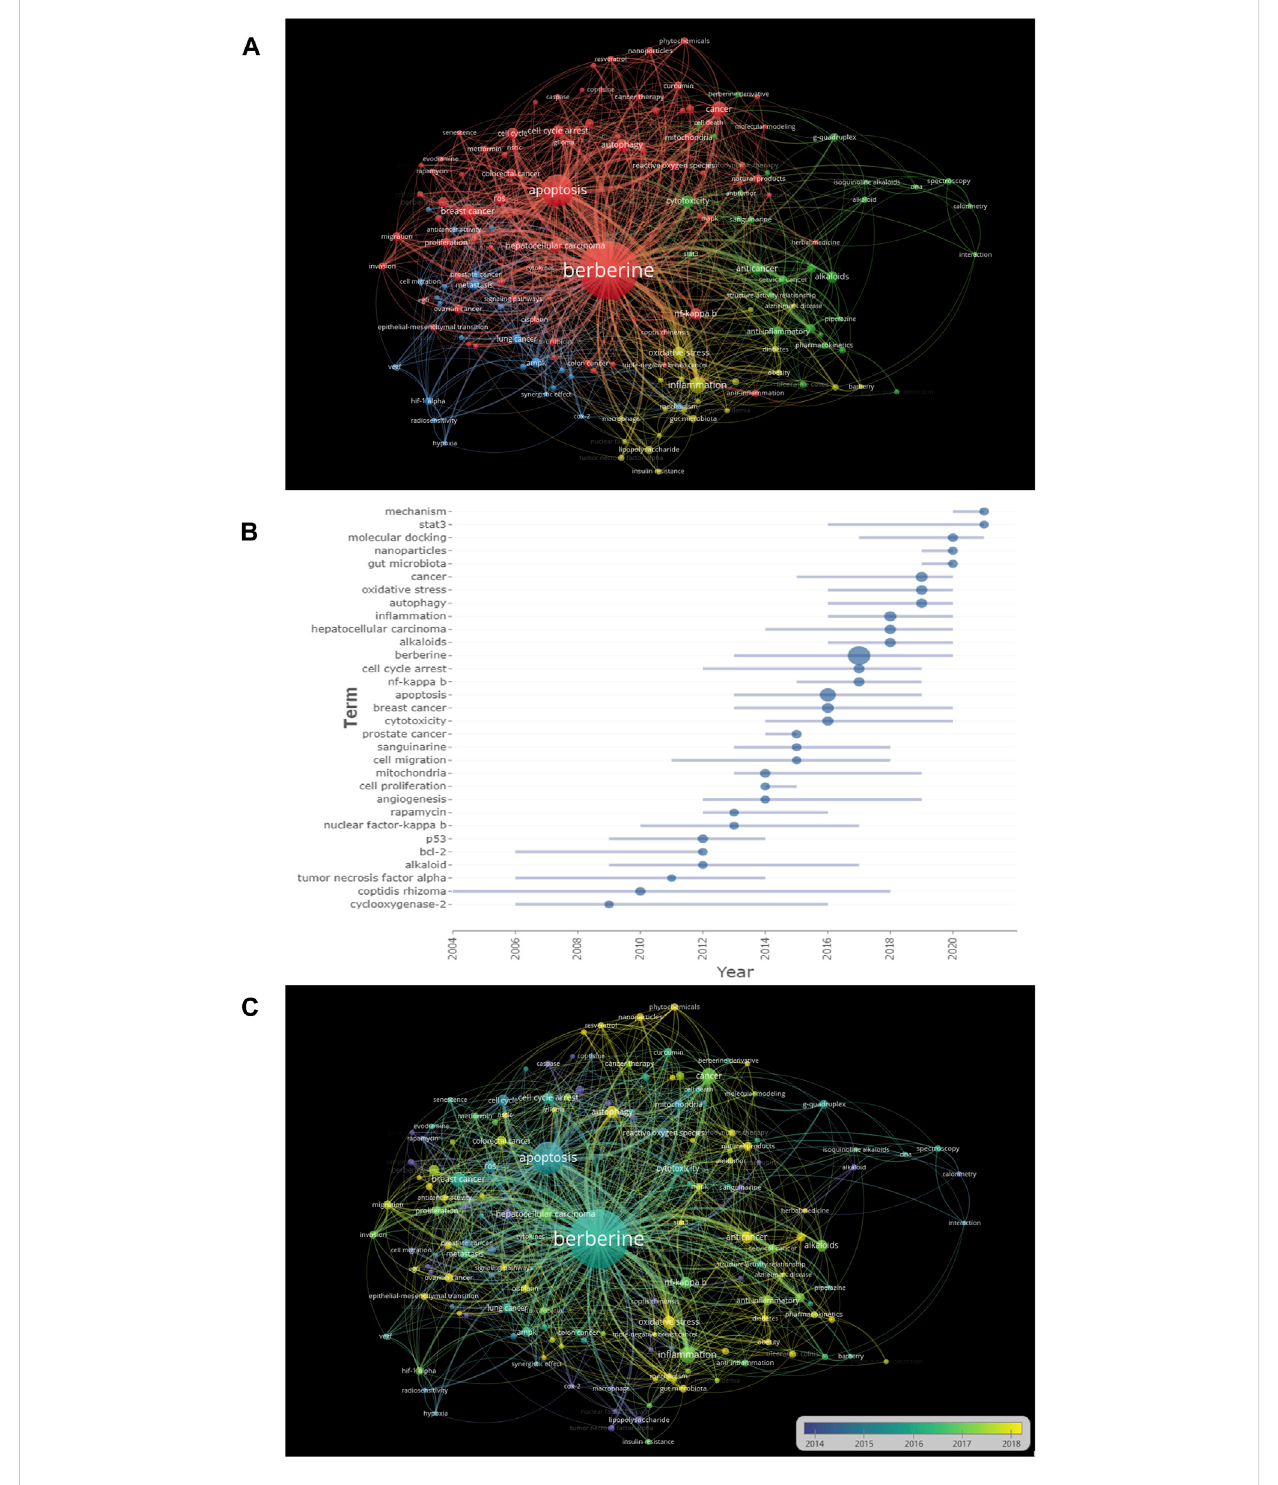
FIGURE 7 Analysisofkeywords (A) thechangingtrendofresearchkeywordsfrom2002to2021. (B) Theevolutionofkeywordfrequency. (C) Thenetworkmap of keywords. Minimum number of occurrences of keywords ≥